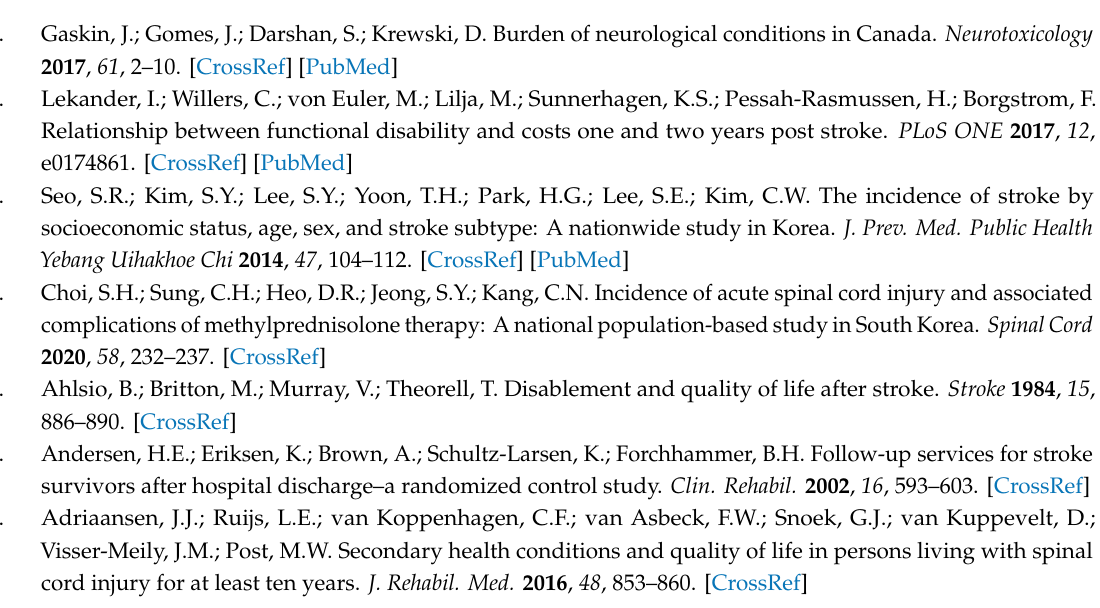
Table S1: ICD-10 codes for acquired brain and spinal-cord injuries. Author Contributions: The conception and design of the study, and data acquisition, analysis, and interpretation were performed by S.Y.Y., J.-H.L., and W.H.K. Drafting the article and revising it critically for important intellectual content was the responsibility of S.Y.Y., J.-H.L., and J.L. Final approval of the version to be submitted was given by S.Y.Y and J.-H.L. All authors have read and agreed to the published version of the manuscript. Funding: This work was funded by the Korea Workers’ Compensation and Welfare Service (grant number